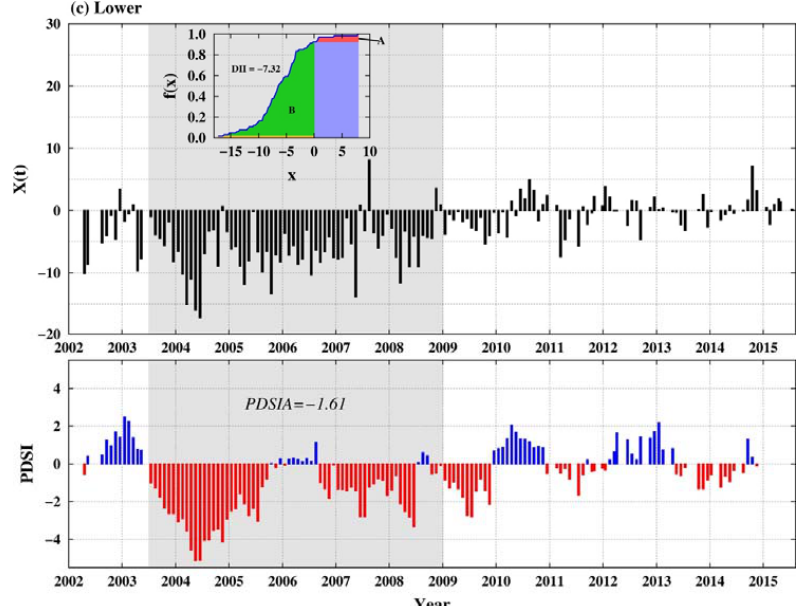
Figure 6. Differences x ( t ) between TTWS and NTWS (black cylinders) from April 2002 to July 2015 and the Palmer Drought Severity Index (PDSI) (blue and red cylinders) between April 2002 and December 2014 in the ( a ) upper, ( b ) middle, and ( c ) lower sub-basins of the YRB. The blue line in the top window represents the empirical cumulative distribution function (ECDF) of x(t) between June 2003 and December 2008. The Dam Influence Indexes (DIIs) relative to the PDSIAs in the three regions between June 2003 and December 2008 are also shown. Note: DIIs were calculated by subtracting the area of the green block from the red block (i.e., DII = A(area) − B(area)), and PDSIAs were calculated using Equation (9).